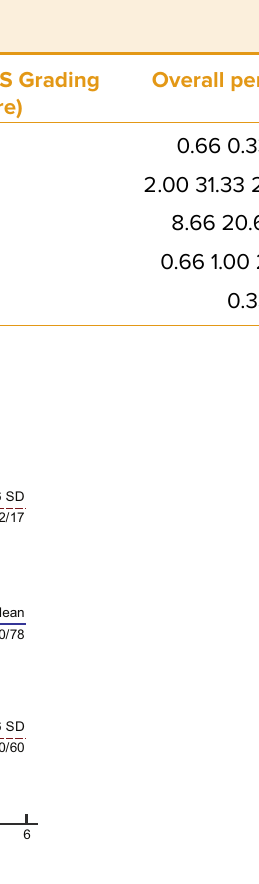
Figure 1. Bland-Altman Plot for LOCS III and PNS Grading Score